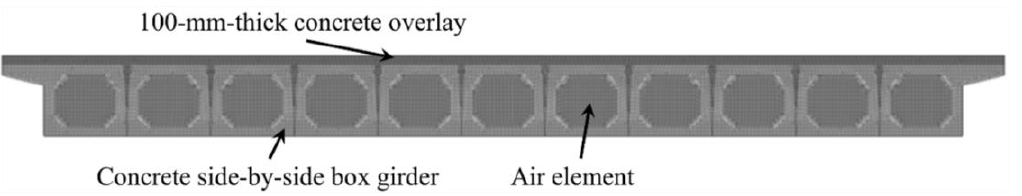
Figure 15. Layout of cross-section of side-by-side box girder (cm).